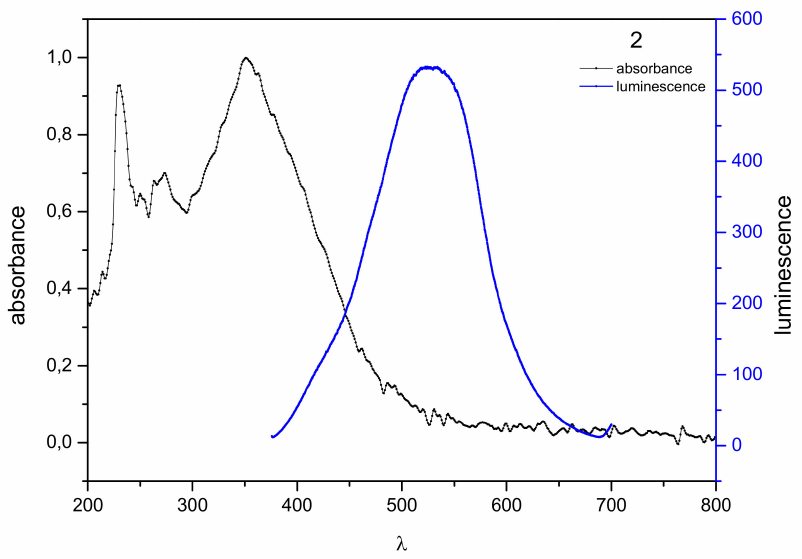
Figure 2. Normalized absorption spectra (black) and emission spectra (blue) of 2 in dichloromethane solution (10 − 6 mol / dm 3